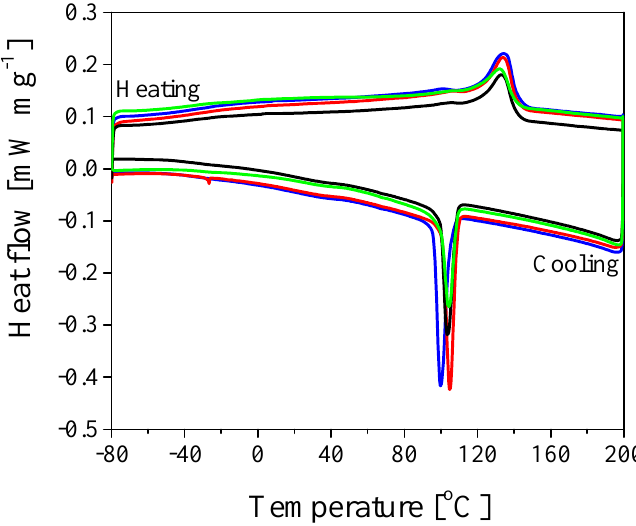
Figure 3. DSC of the composite gel obtained after one passage through the microchannel at different percentages of the fillers, silica NPs. Blue curve: PVdF-HFP; Red curve: PVdF-HFP + 10% SiO 2 ; Black curve: PVdF-HFP + 20% SiO 2 ; Green curve: PVdF-HFP + 30% SiO 2 .